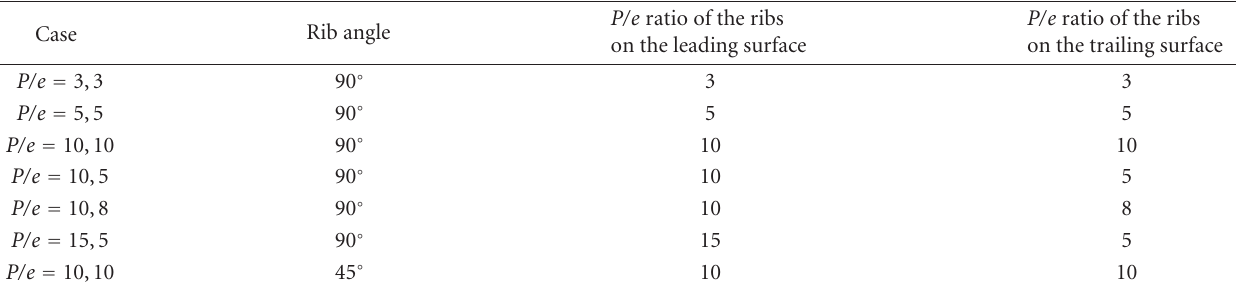
Table 1: List of configurations